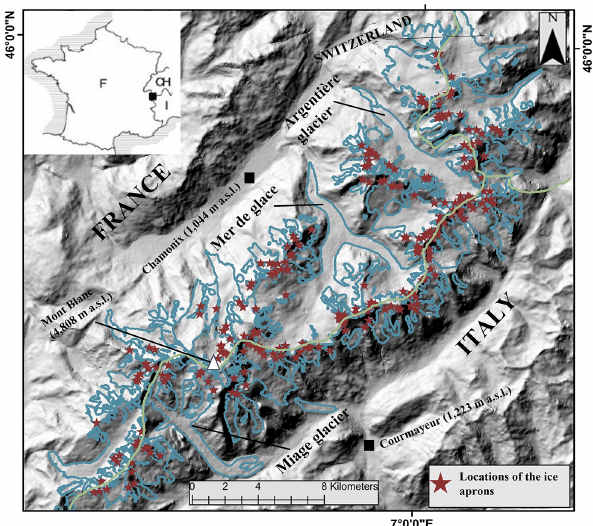
Figure 1. The Mont Blanc massif (western European Alps). A total of 200 IAs (red stars) were digitized accurately on high- resolution images. The glacier outlines (in blue) come from Gardent et al. (2014). The green line shows the border between France, Italy and